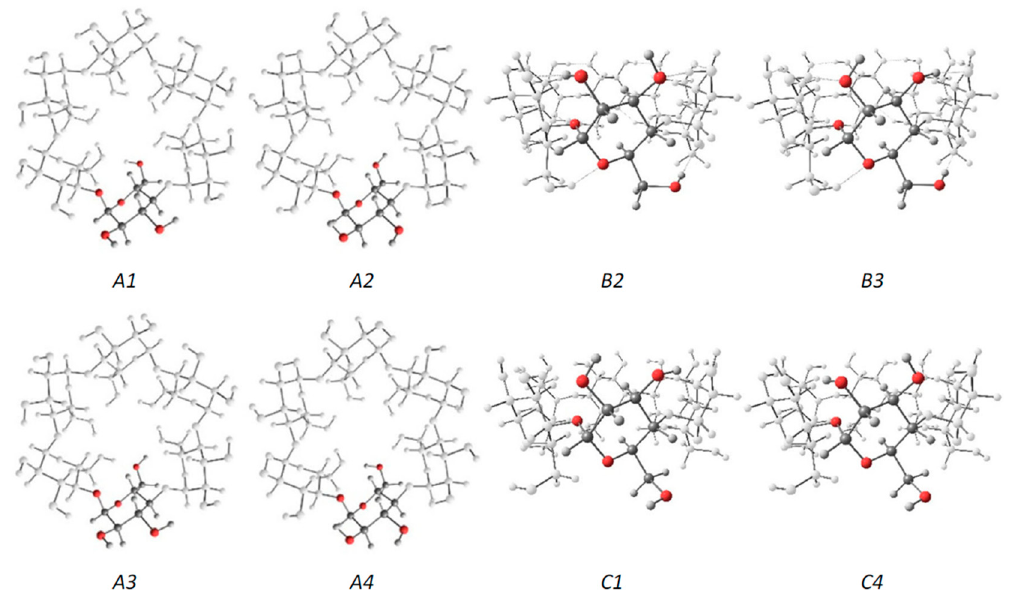
Figure 3. The three series of α -CD conformers. Each glucose unit is filled in for easier visualization. Reprinted with permission from Springer Nature, Springer-Verlag, J. Mol. Model. Reference [128], COPYRIGHT (2008).